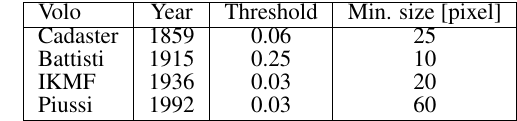
Table 3. Optimal segmentation parameters for historical maps datasets.